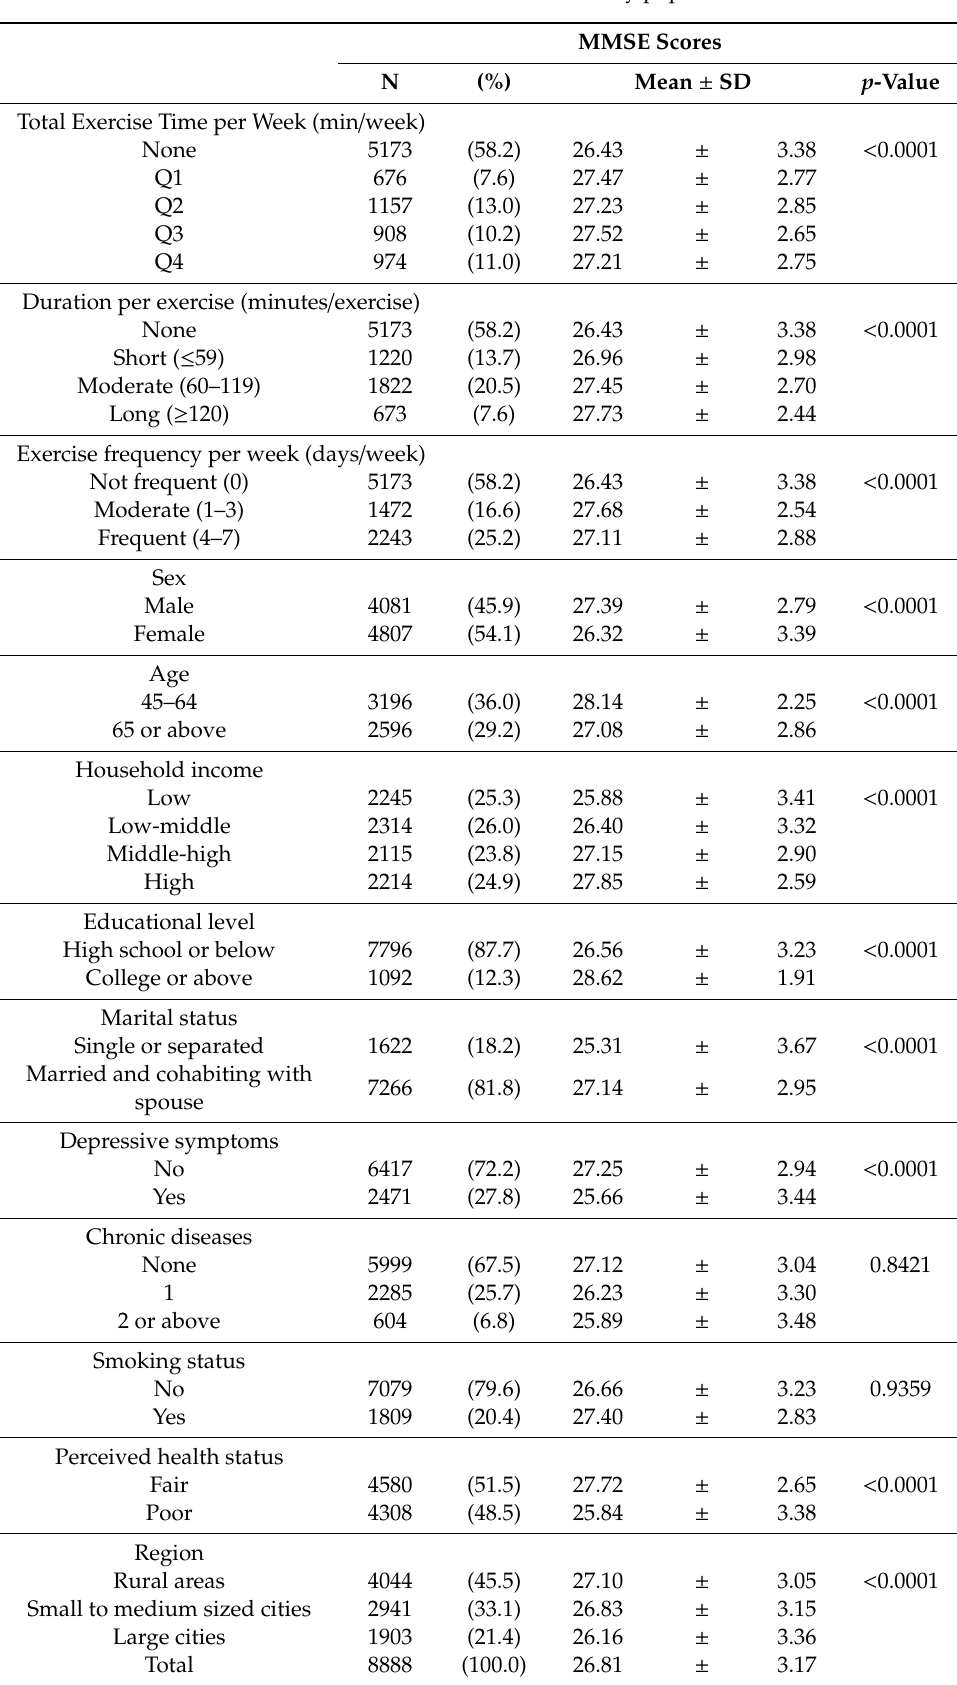
Table 1. General characteristics of the study